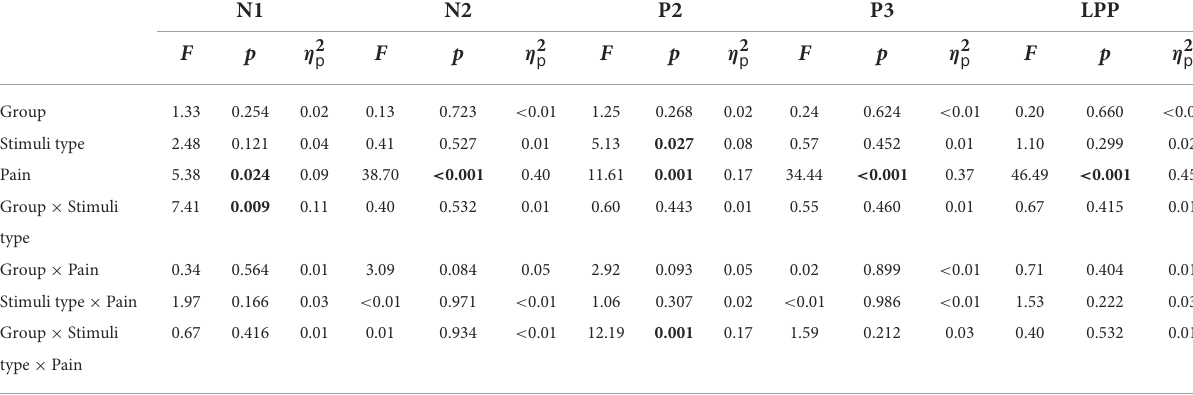
TABLE 3 Summary of statistical analyses of ERP amplitudes.